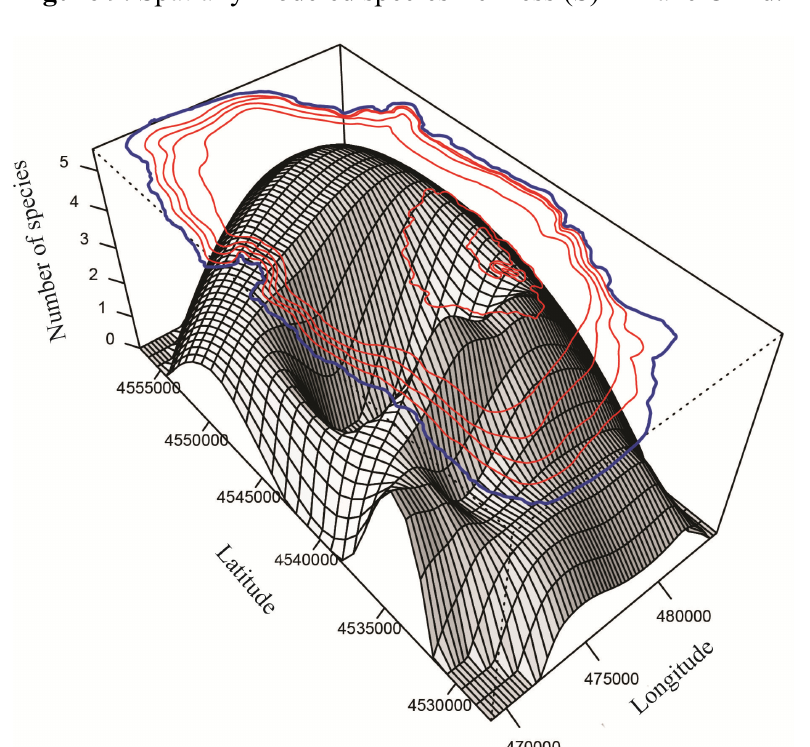
Figure 9. Spatially modeled species richness (S) in Lake